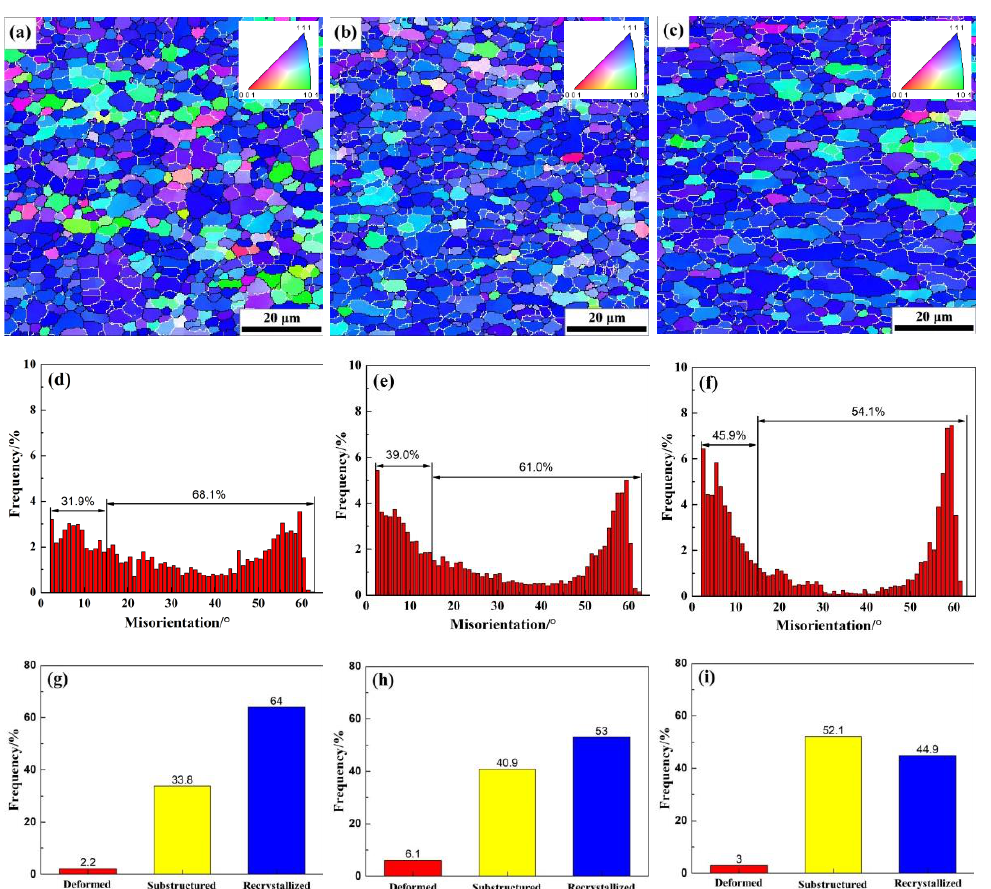
Figure 2. Electron backscattered diffraction (EBSD)maps (top surface layer (ED – TD) plane) of grain orientation and distribution of grain boundary angles and recrystallization microstructures of alloys with different Zn/Mg ratios ( a , d , g ) 1# alloy; ( b , e , h ) 2# alloy; ( c , f , i ) 3# alloy.